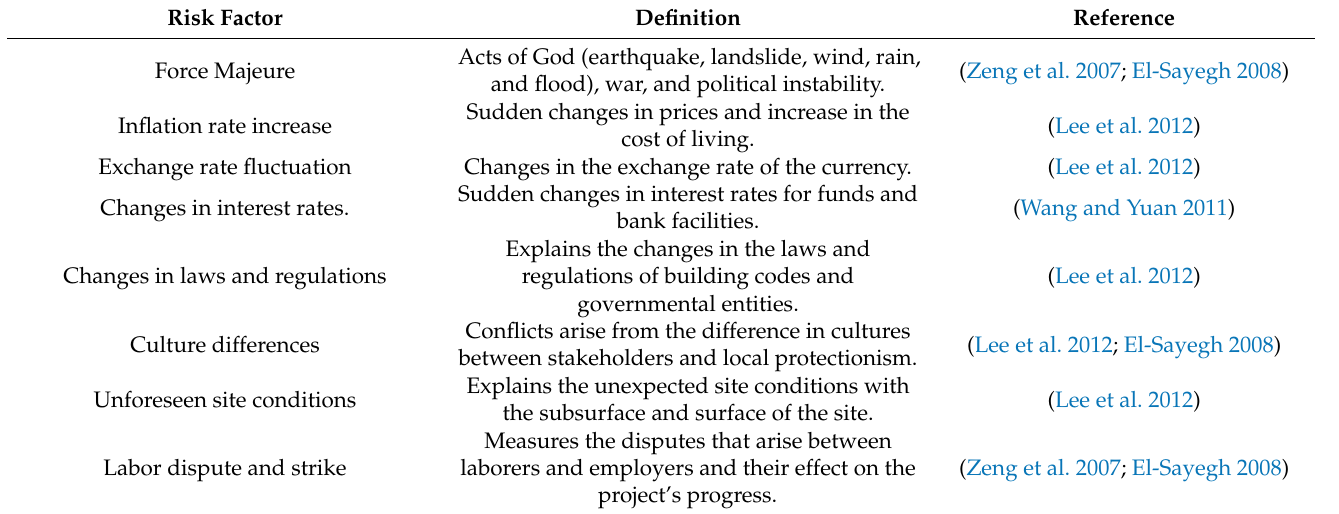
Table 4. Risk factors related to cash low forecasting attributed to external